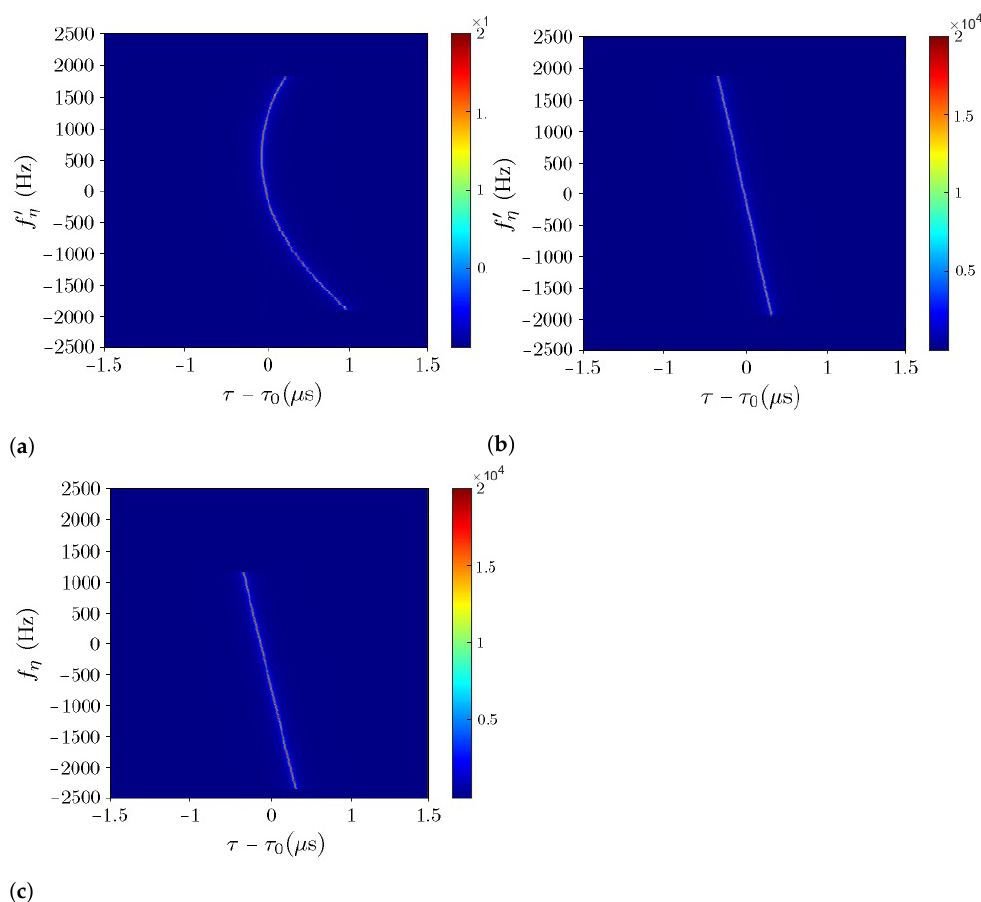
Figure 7. Magnitude of ( a ) S q ( τ , f (cid:48) ) , Doppler spectrum after second RCMC, and ( c ) S q ( b ) S q η 12 solving ADA